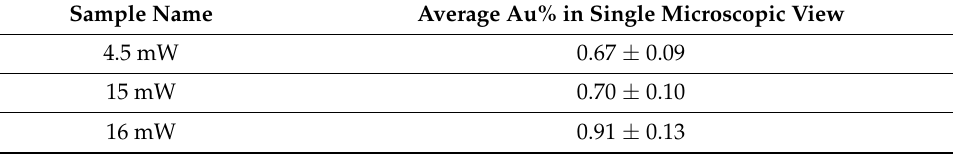
Table 4. Average filling level of Au NPs.